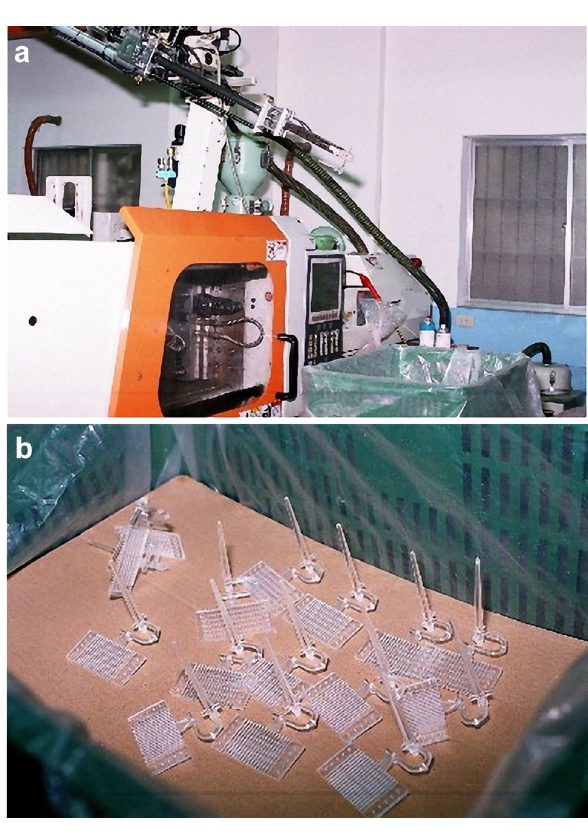
Figure 8. Injection molding machines and PMMA bipolar plate by injection